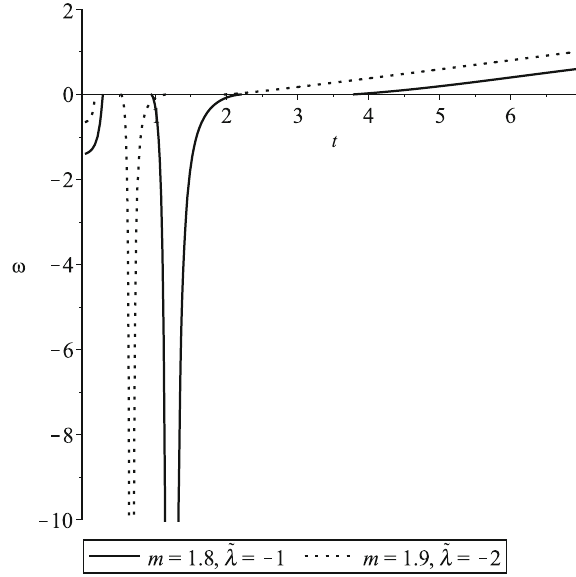
Fig. 6 Kinetic function ω for different values of ˜ λ < 0 and m >